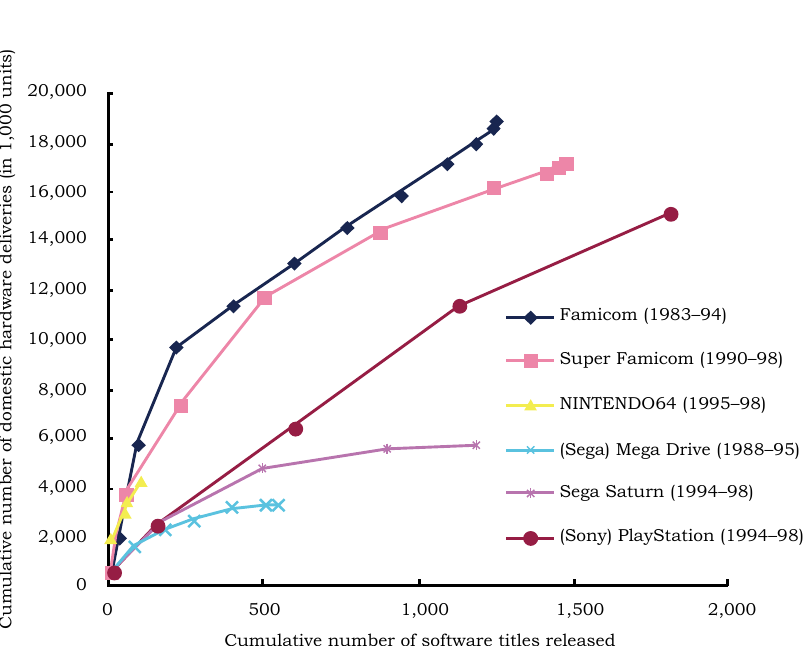
Figure 2. Correlation between hardware and software in Japanese console game